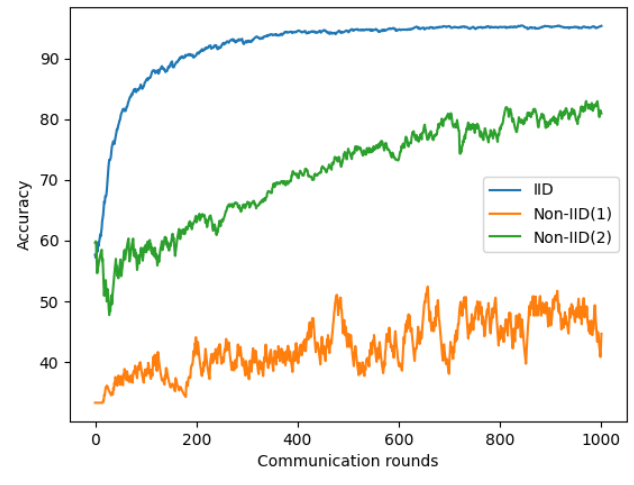
Figure 10. Performance comparison between IID and Non-IID based on chest X-ray images. A similar observation was made with the symptom dataset; Figure 11 and Table 7 show a 1.28% to 2.29% reduction in accuracy in Non-IID(1) compared to IID. Table 6. The summary table of the performance comparison between IID and Non-IID based on chest X-ray images.